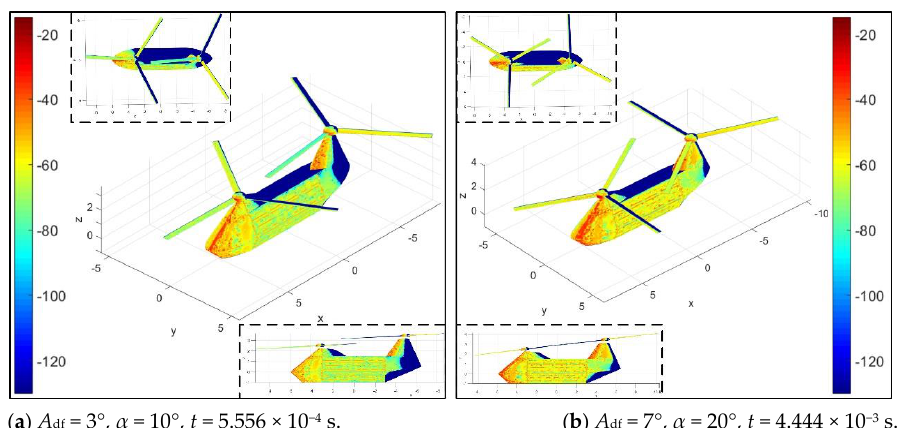
Figure 11. Surface scattering characteristics of helicopter at various A df , f RH = 10 GHz, n r1 = n r2 = 1200 r/min, β = 0°, A dr = 0°, γ = θ = 0°, RCS unit: dBm 2 .